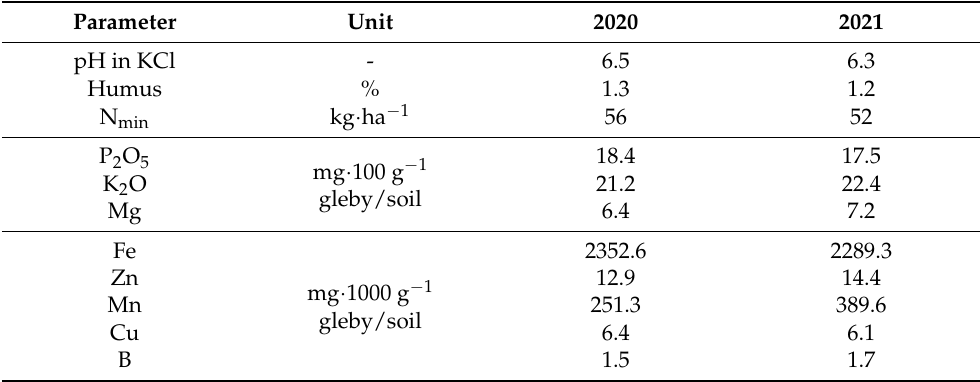
Table 1. Soil analysis under field experiment (0–30 cm).